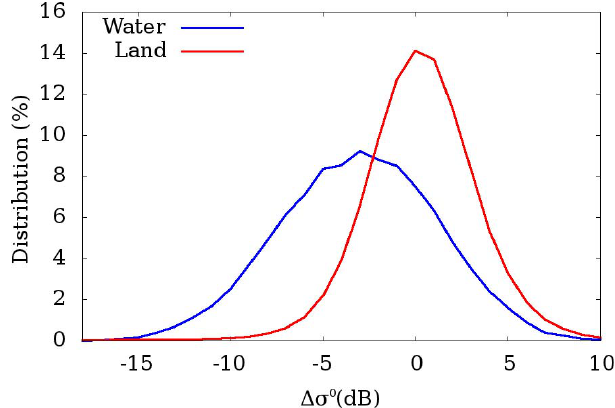
Fig. 7. Probability density functions for 1σ 0 for water and land over the flooded region on 29 August 2010, as determined by clas- sification using MODIS SWIR Reflectance Threshold of